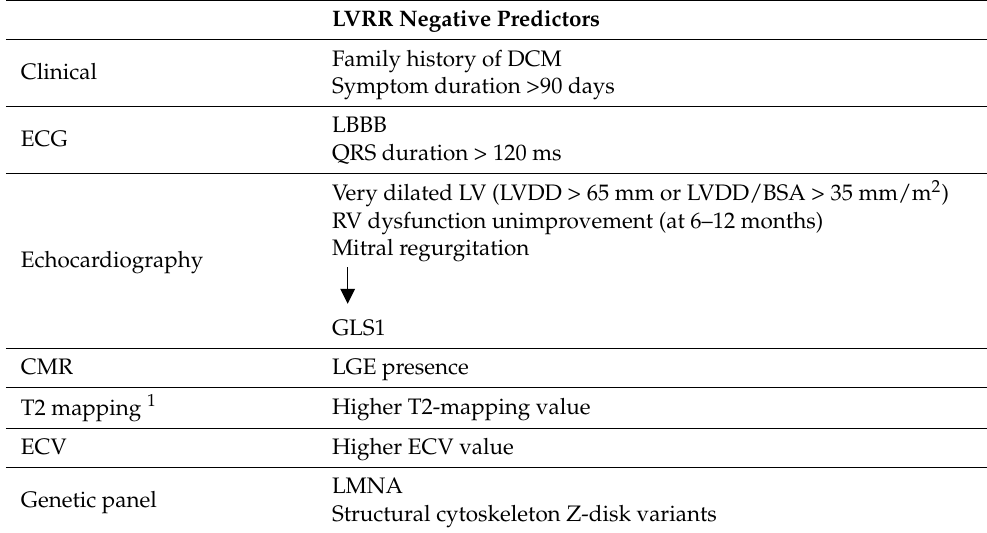
Table 2. Multiparametric approach to arrhythmic risk stratification in dilated-cardiomyopathy pa- Table 3. Negative predictors of left ventricular reverse remodelling in dilated-cardiomyopathy patients.